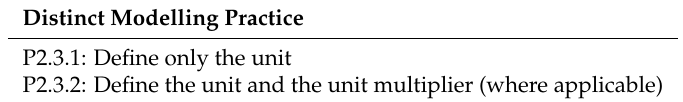
Table 22. Publishing modelling practices of data portals for the unit of the measure. Portal Modelling Practice Scottish Defines only the unit DCLG Defines only the unit ISTAT N/A Irish CSO N/A VLO Defines only the unit e-Stat Defines the unit and the unit multiplier ( estat:unitMult property) The distinct practices are presented in Table 23.